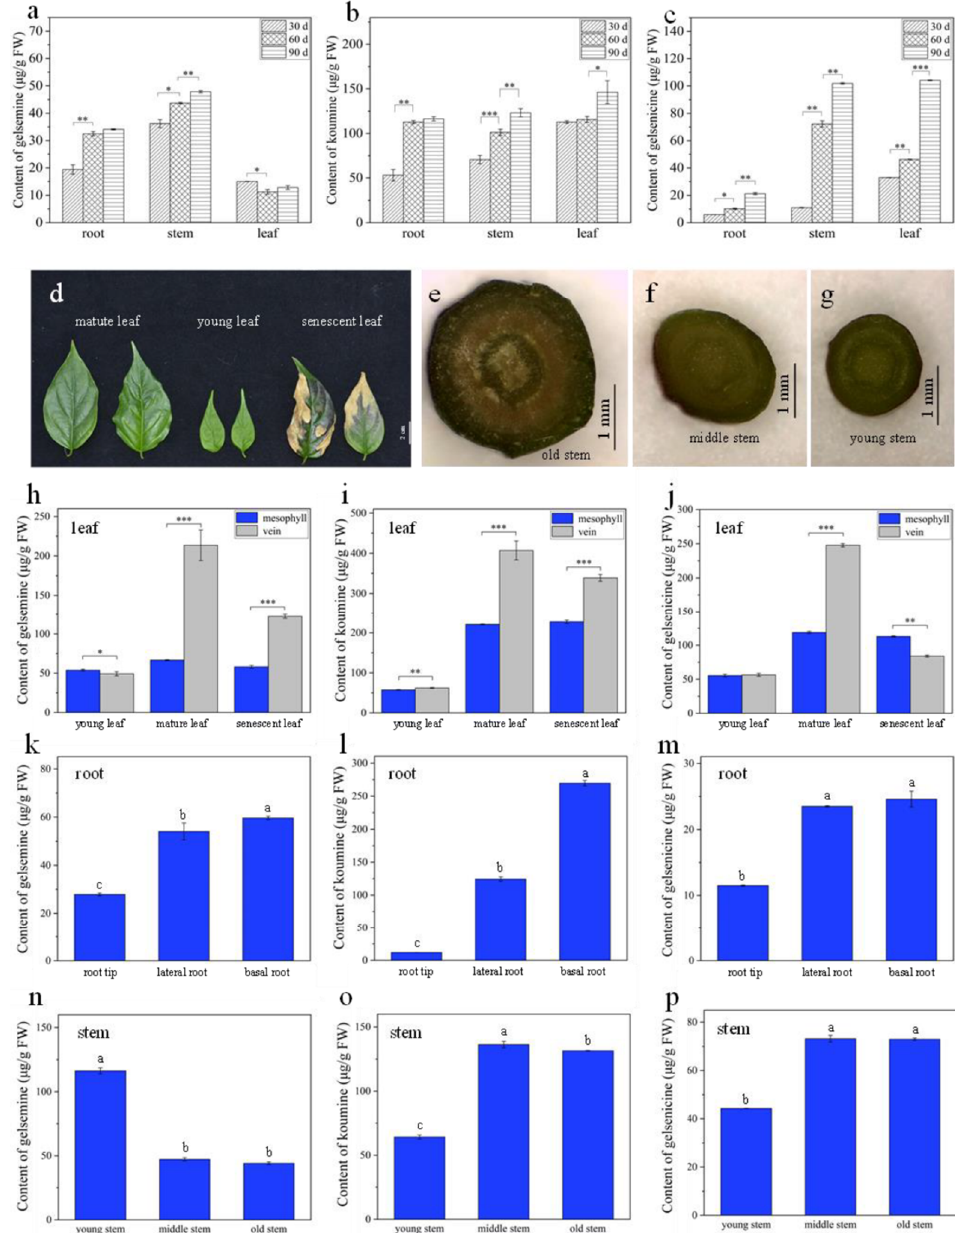
Figure 4. Quantification of three alkaloids in different parts of G. elegans . ( a – c ) The contents of three alkaloids in the roots, stems and leaves of 30, 60, and 90 day old G. elegans ; ( d ) different old leaf of G. elegans ; ( e – g ) cross-sections of different parts of G. elegans stem; ( h – j ) contents of gelsemine, koumine, and gelsenicine in different old parts of leaf; ( k – m ) contents of gelsemine, koumine, and gelsenicine in different old parts of root; ( n – p ) contents of gelsemine, koumine, and gelsenicine in different old parts of stem. The error bars indicate the standard deviations of three biological replicates, and asterisks represent statistically significant differences as determined by Fisher’s least significant difference (* p < 0.05, ** p < 0.01, *** p < 0.001). The presence of the same lowercase letter denotes a non-significant difference between the means ( p < 0.05).